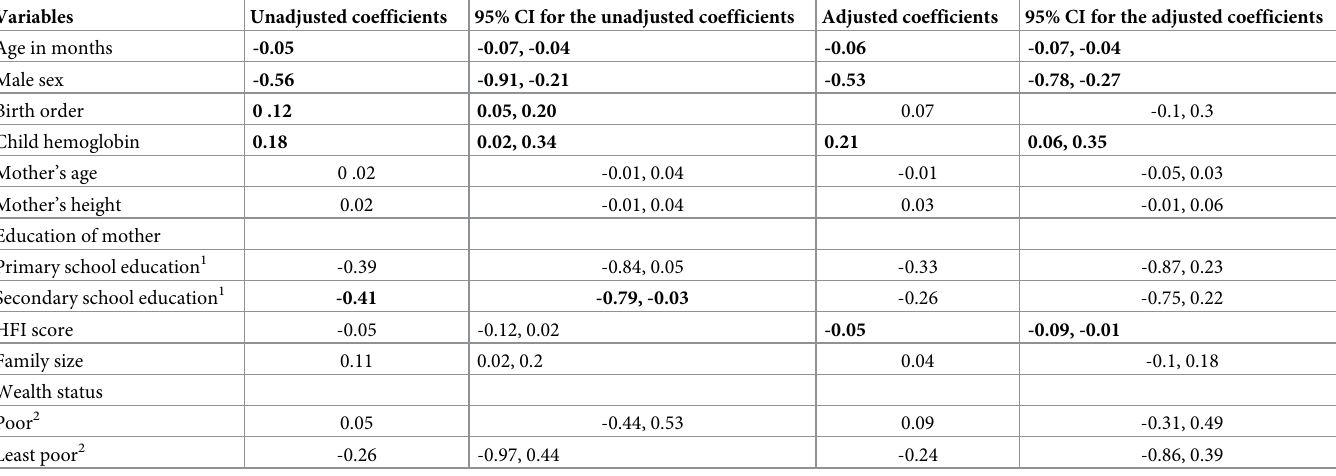
Table 5. Effect of selected predictor variables on length-for-age z-scores among 903 children 0 to 24 months of age in Dale district, southern Ethiopia, 2018.